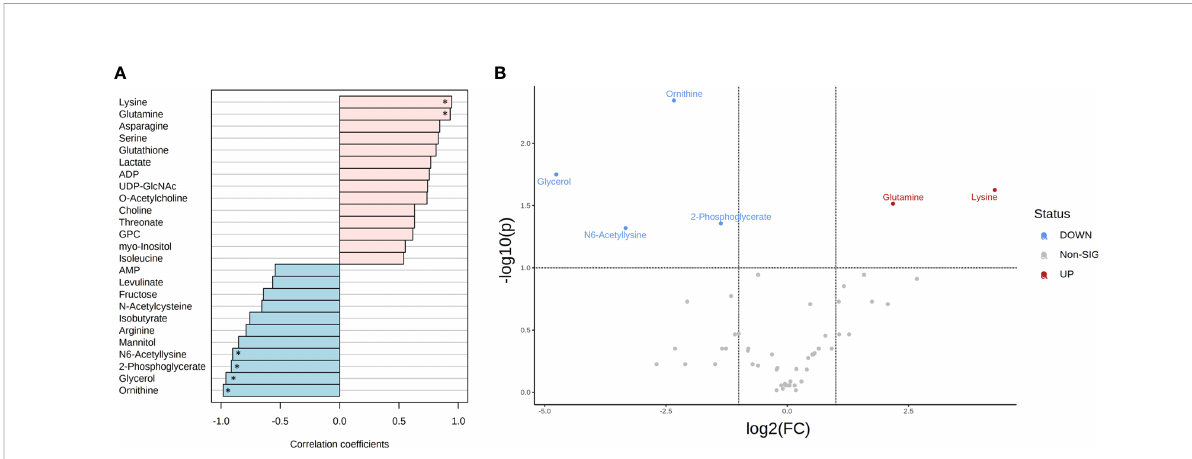
FIGURE 3 Metabolite correlation and signi fi cant differences in the metabolome of T. reesei and A. niger grown on glucose for 48 h. (A) List of the top 25 metabolites with higher correlation patterns in T. reesei (pink) and A. niger (blue). Metabolites having Pearson correlation > 0.7 and FDR < 0.1 are marked (*). (B) Volcano plot of metabolites with signi fi cant difference between both fungi. Metabolite levels were increased (red) or reduced (blue) in T. reesei compared to A. niger . ADP, adenosine diphosphate; UDP-GlcNAc, uridine diphosphate N-acetylglucosamine; GPC, sn- glycero-3-phosphocholine; AMP, adenosine